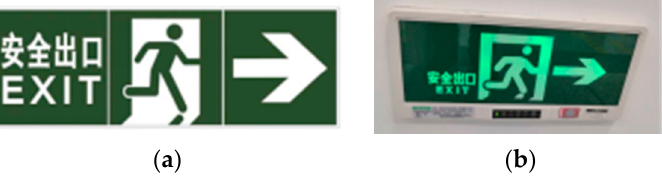
Figure 1. The current color combination of safety sign in China. ( a ) “Green and white”, from Chinese GB 13495.1-2015 ( Fire Safety Signs-Part 1: Signs ), and Chinese GB/T 23809-2009 ( Safety Way Guidance Systems-Setting Principles and Requirements ), etc.; ( b ) “Green and black”, the real visual effect after charging in Zhengzhou Zijing Mountain subway station and the other subway stations in China.